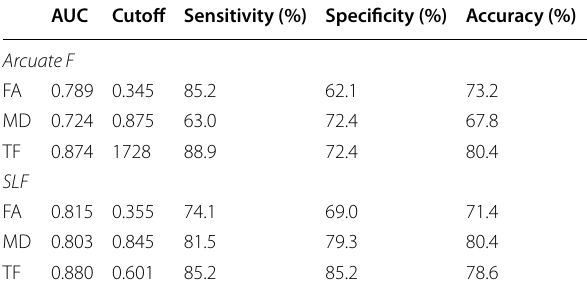
Table 2 Results of ROC curve with calculation of AUC, cutoff, accuracy, sensitivity, and specificity of FA and MD (10 − 3 mm 2 /s) and number of TF used to differentiate patients and control AUC Cutoff Sensitivity (%) Specificity (%) Accuracy (%) Arcuate